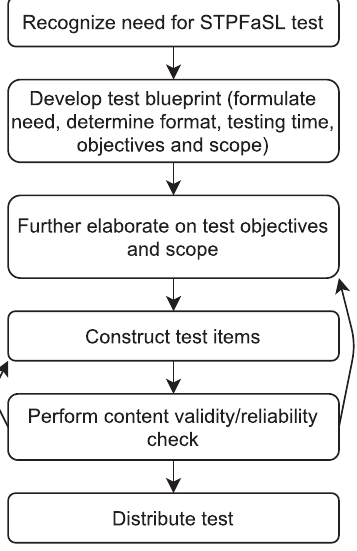
FIG. 1. A schematic diagram of the STPFaSL instrument development process.